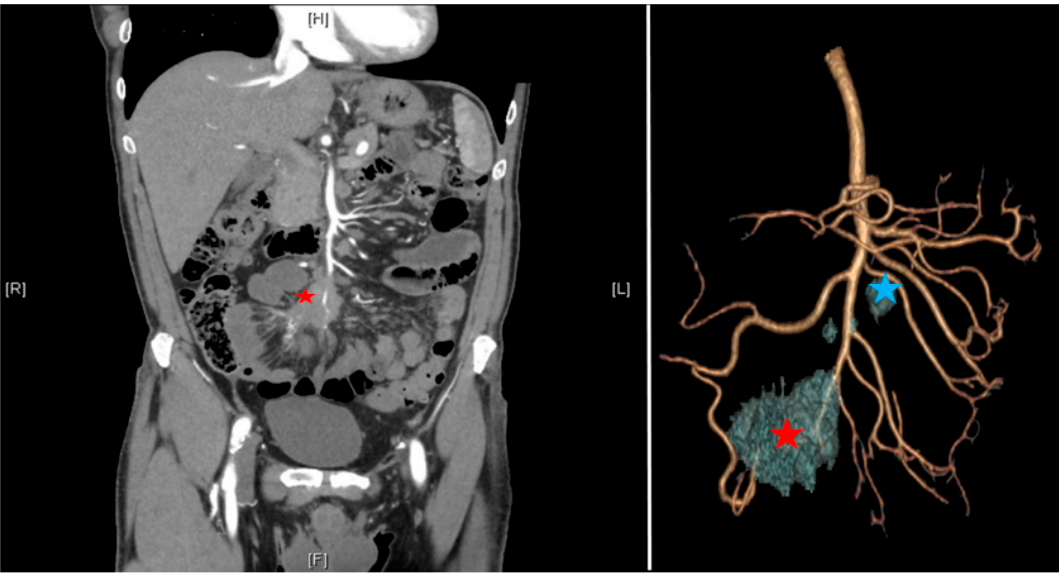
Figure 2. CT scan with arterial three-dimensional reconstruction; mesenteric mass (red star); proximal nodes (group 3 down from Deguelte et al. [13] in blue star).